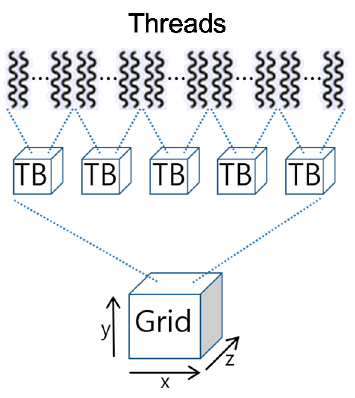
Figure 1. Grouping a certain number of threads to TB (Thread Blocks) in a GPGPU task. Appl. Sci. 2020 , 10 , x FOR PEER REVIEW